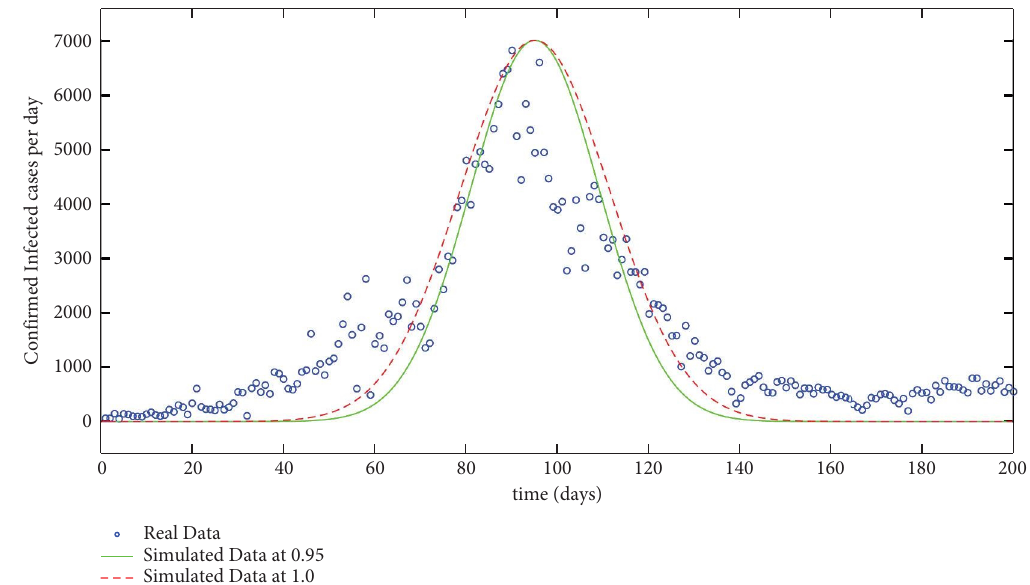
Figure 26: Comparison between real reported infected cases with simulated data at two diferent fractional